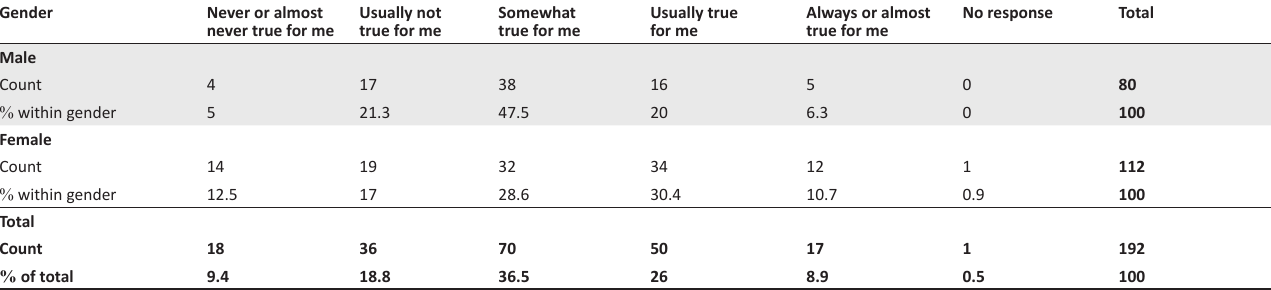
TABLE 4a: The significant difference between the perceived strategies by learners and gender. (Question: When information is critical to my understanding of the text is no directly stated, I try to infer that information from the text.) Gender Never or almost Usually not Somewhat Usually true Always or almost never true for me true for me true for me for me true for me